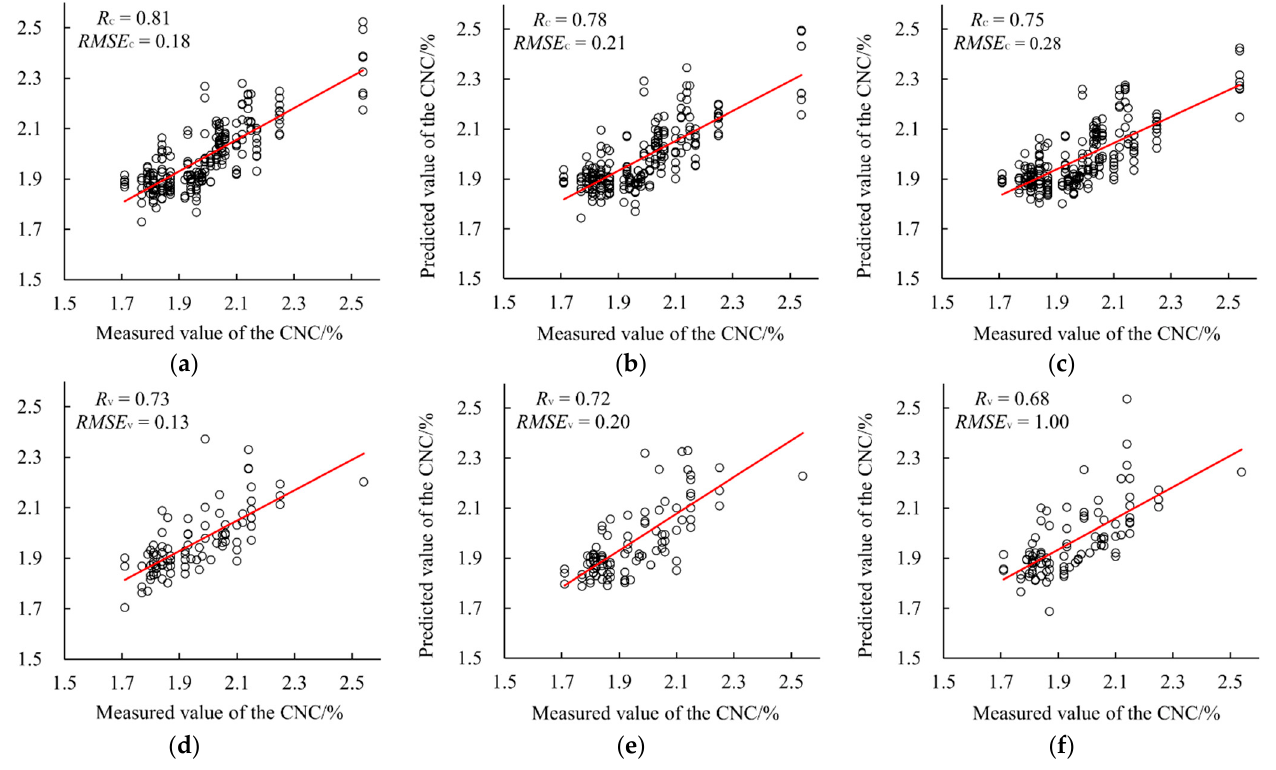
Figure 6. The CNC prediction results of the PLS, and BPNN ELM models based on the five-band reflectance. ( a ) The calibration result of the PLS model; ( b ) the calibration result of the BPNN model; ( c ) the calibration result of the ELM model; ( d ) the validation result of the PLS model; ( e ) the validation result of the BPNN model; ( f ) the validation result of the ELM model.